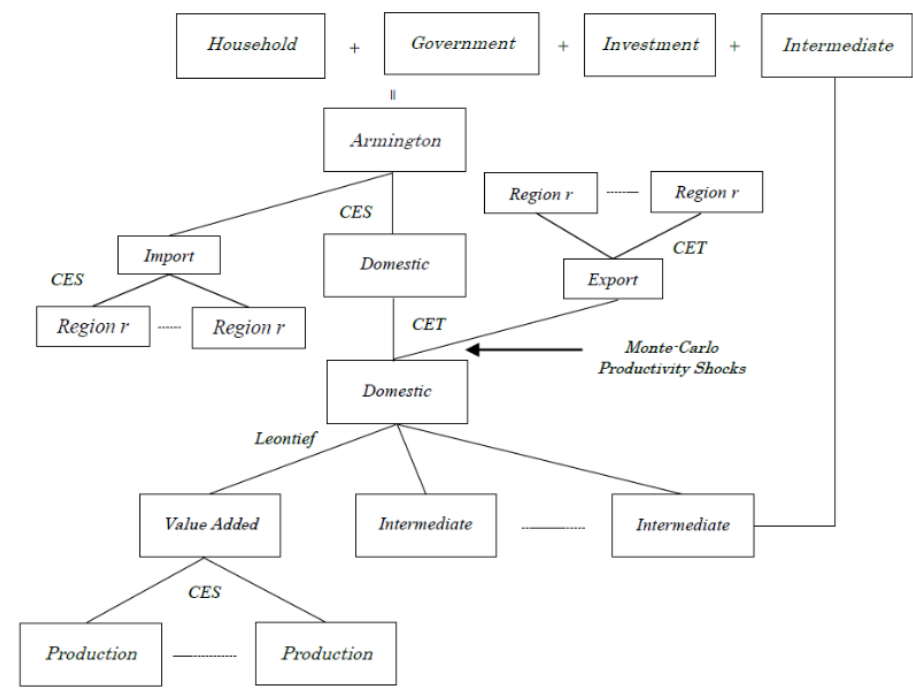
Figure 2. Overview of the model.